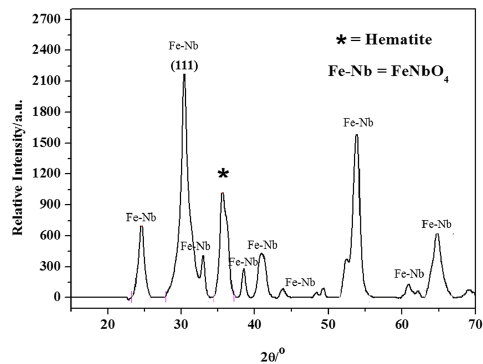
Figure 1. X-ray diffraction pattern of Fe-Nb powder synthesized from combustion reaction.